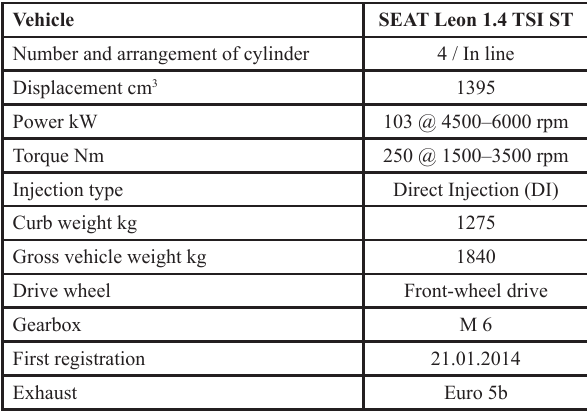
Fig. 1. Test vehicle with installed PEMS on chassis dynamometer Table 1. Data of tested gasoline (GDI)